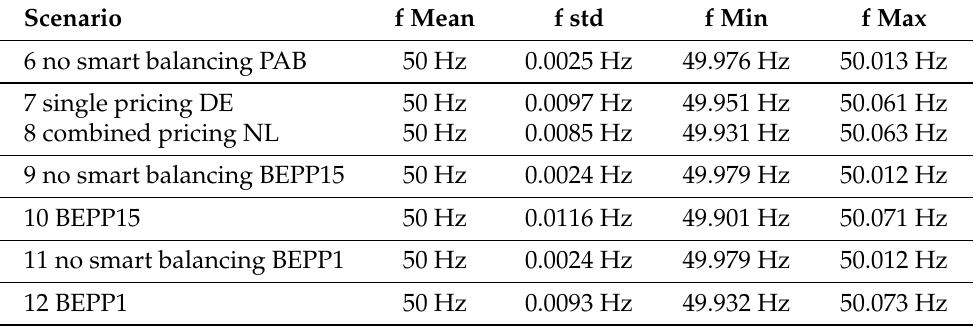
Table 11. Smart balancing simulation: results of scenarios with historic ACE and pay-as-bid